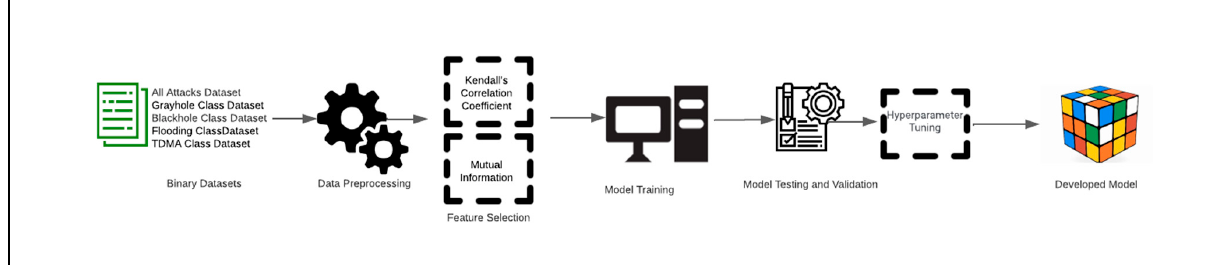
Figure 2. Conceptual diagram for the proposed ML learning methodology’s workflow.